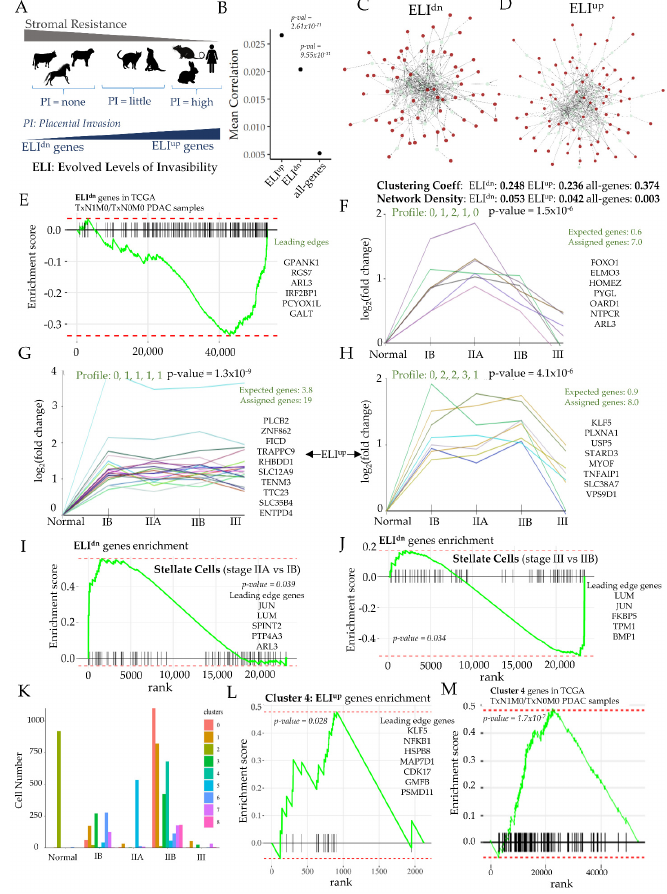
Figure 5. Transition from pre-metastatic to metastatic cancer is accompanied by systemic downregu- lation of evolved stromal resistance and emergence of fibroblast subclass with increased vulnerability to invasion. ( A ) Schematic showing ELI (Evolved Levels of Invasibility) framework highlighting stromal genes which increase expression correlated to increased stromal invasibility (ELI up ) or de- creased stromal invasibility (ELI dn ) to placental or cancer invasion. ELI up genes are predicted to be pro-invasive and ELI dn genes are predicted to be resistive. ( B ) Gene–gene correlation analysis in PDAC fibroblasts for all genes, top 100 ELI up genes, and top 100 ELI dn genes. ( C , D ) Connected subnetworks of ELI up and ELI dn genes in PDAC fibroblasts across all stages created upon Reactome validated protein–protein interaction network; red nodes refer to top 100 ELI up ( C ) or ELI dn ( D ) gene sets, while gray nodes refer to linker genes extracted in Reactome to create a connected subnetwork. ( E ) GSEA enrichment analysis showing negative enrichment of resistive ELI dn genes among the differential gene set between N1 (lymph metastasis) and N0 (no lymph metastasis) PDAC cancers from TCGA database; n (N1) = 312; n (N0) = 116 patients; Additionally, leading edge genes are shown. ( F ) STEM analysis revealed a significant pattern of gene expression changes in fibroblasts across different stages of PDAC cancer within the top 100 ELI dn genes; pattern profile shown in green. ( G , H ) STEM analysis revealed significant patterns of the top 100 ELI up genes whose expression changes with stages of cancer are significant. ( I , J ) Enrichment of ELIdn set in stellate cells among the differential genes between stage IIA and IB ( I ), and between stages III and IIB ( J ); leading edge genes and p -values are shown in panel. (K-M) Stromal trespass of cancer from primary lesion to proximal lymph nodes is accompanied by emergence of a fibroblast subclass with ELI predicted pro-invasive phenotype; ( K ) Distribution of fibroblast clusters determined in Figure 1A across different stages of PDAC cancer; ( L ) GSEA enrichment of ELI up genes within the cluster 4 upregulated gene set. ( M ) GSEA enrichment of cluster 4 upregulated genes among the differential gene set between N1 (lymph metastasis) and N0 (no lymph metastasis) samples from a larger cohort of bulk RNAseq data from